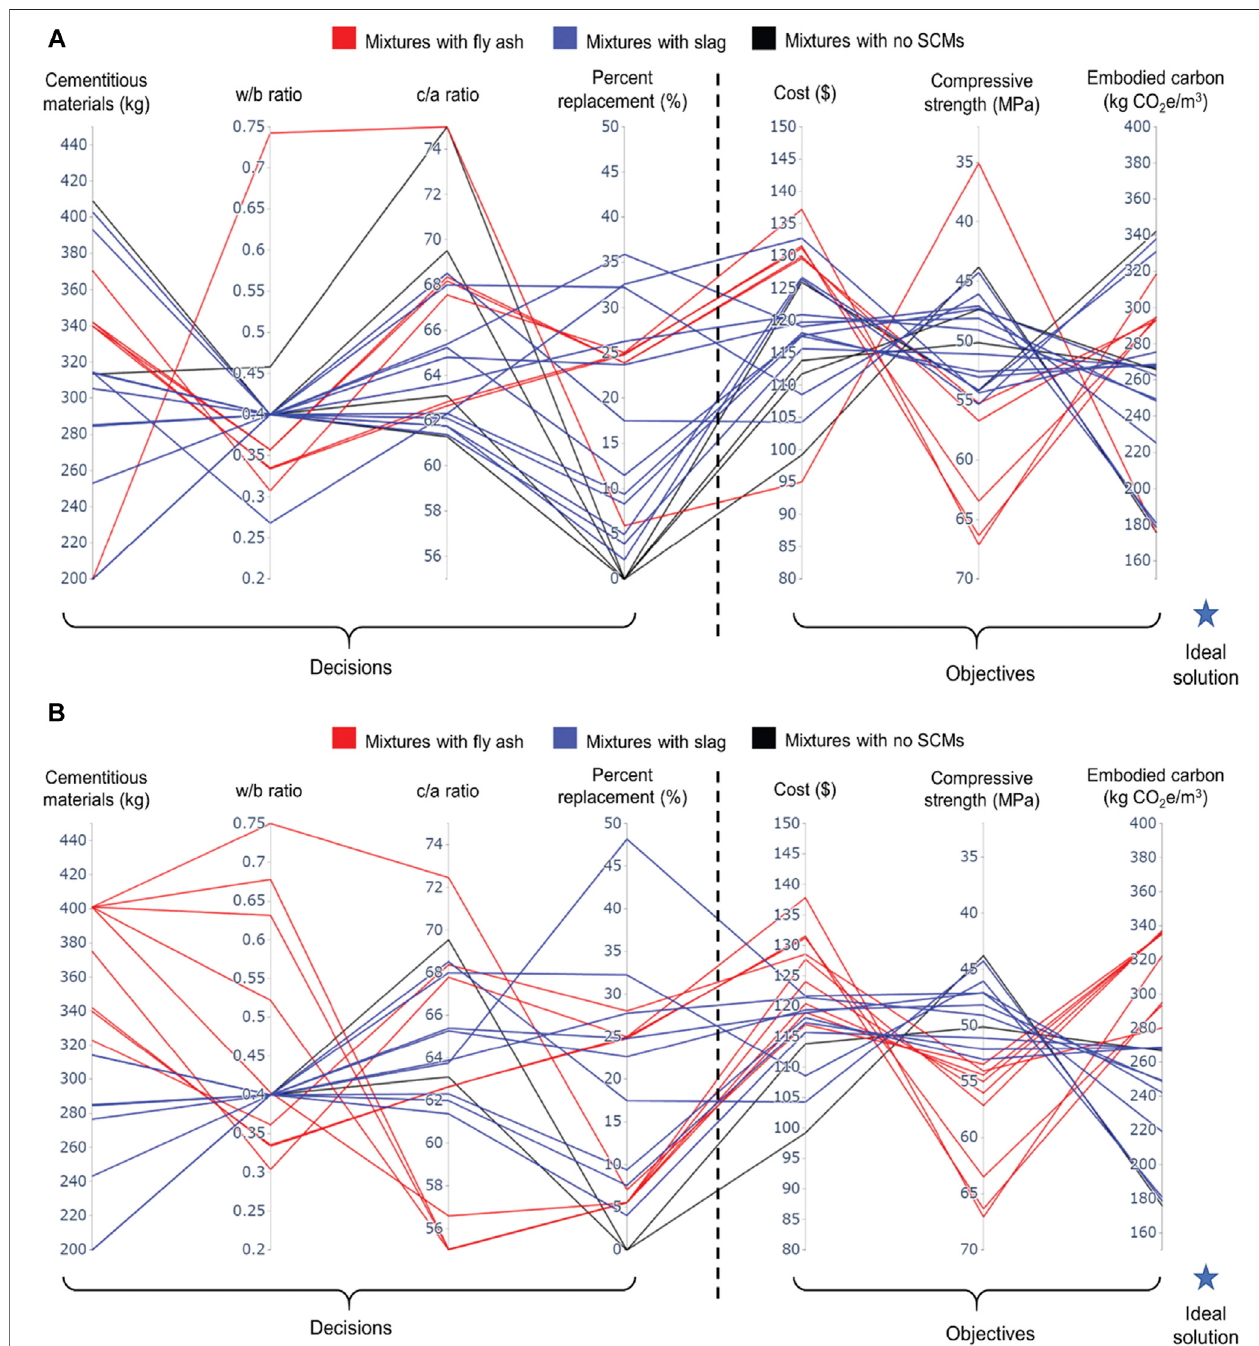
FIGURE 5 | Pareto-optimal solutions for (A) Case 3a and (B) Case 3b, which illustrates the importance of climate change accounting regarding prevention of corrosion in chloride-laden conditions.